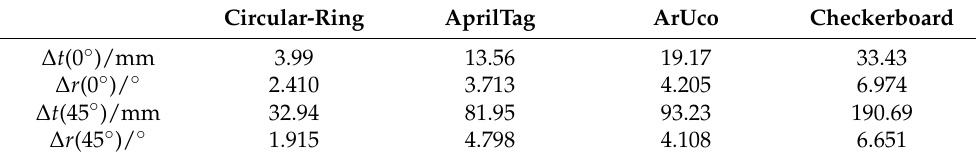
Table 5. The maximum Euclidean distance of translation error and rotation error.